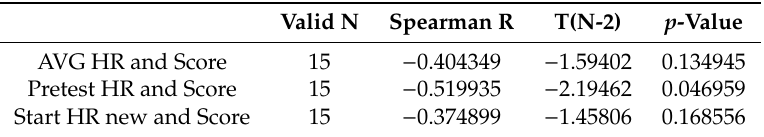
Table 3. Spearman